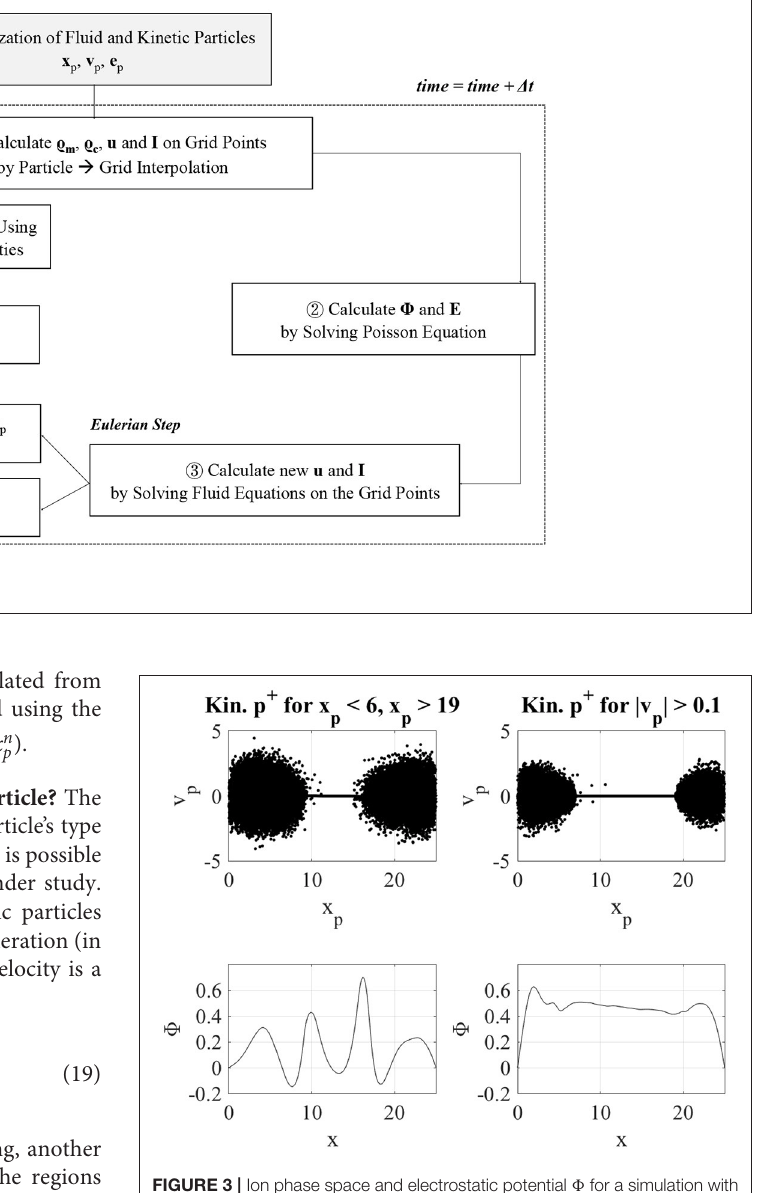
FIGURE 3 | Ion phase space and electrostatic potential 8 for a simulation with ions becoming kinetic when entering the regions x < 6 and x > 15 (left panels). An artificial sheath between the kinetic and the fluid ions is formed. In the right panels, ion phase space and electrostatic potential 8 is shown for a simulation with ions becoming kinetic when their velocity is greater than a threshold velocity (0.1). In this case, the artificial sheath is not formed.